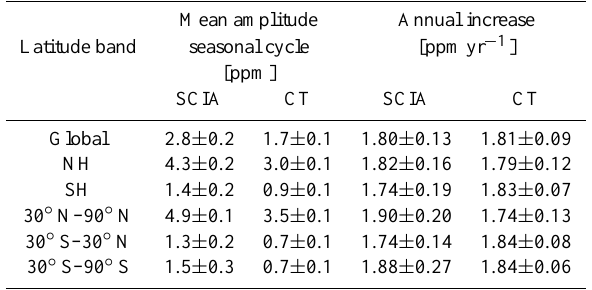
Table 1. Mean amplitude of seasonal cycle and annual increase for SCIAMACHY and CarbonTracker XCO 2 for the two hemispheres and other latitude bands (see main text for